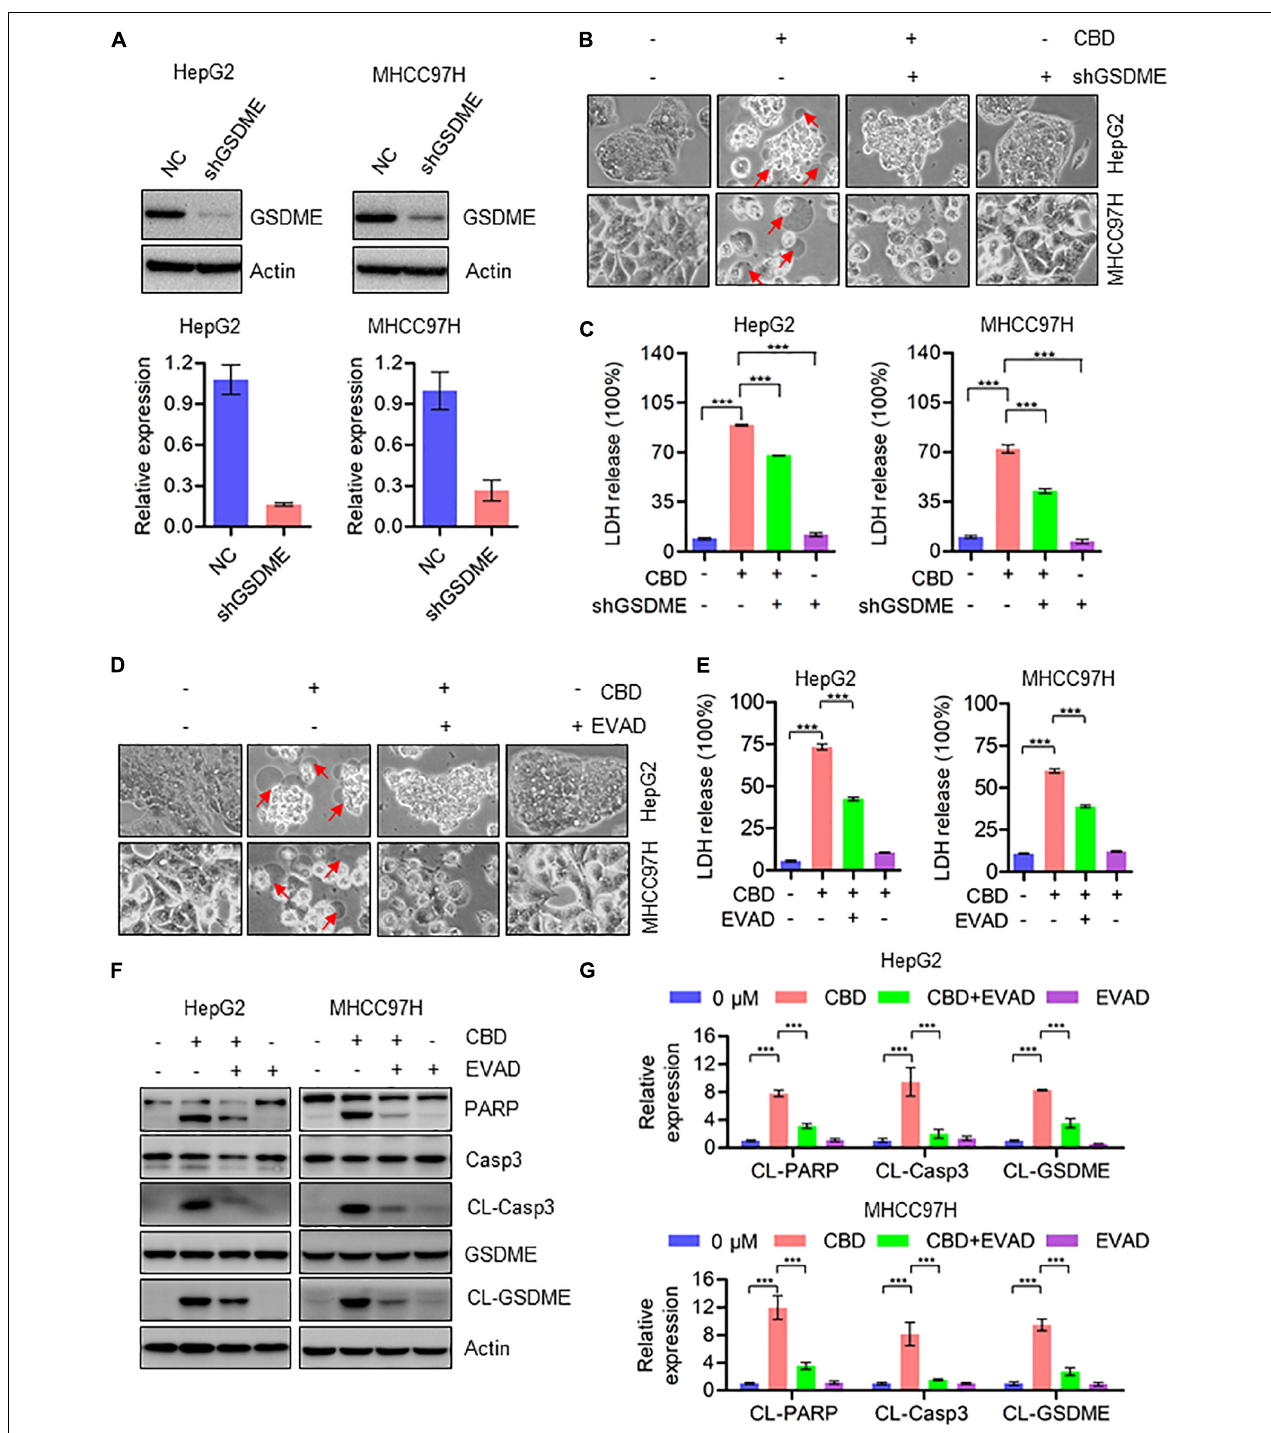
FIGURE 3 | Activation of caspase3/GSDME axis is essential for CBD-induced pyroptosis. (A) Western blot was performed to detect the efficiency of GSDME knockdown in HepG2 and MHCC97H cells. Actin was used as a loading control. The graphs represent the mean ± SD. (B) Representative morphological changes in control and GSDME knockdown HepG2 and MHCC97H cells after CBD exposure. (C) LDH release assays were performed on control and GSDME knockdown HepG2 and MHCC97H cells after CBD administration. (D) Representative morphological changes in CBD-treated HepG2 and MHCC97H cells with or without EVAD. (E) LDH release assays were performed on CBD-exposed HepG2 and MHCC97H cells in the presence or absence of EVAD. (F,G) Western blot analysis of PARP, Caspase-3, CL-Caspase-3, GSDME, and CL-GSDME in CBD (40 µ M) treated HepG2 and MHCC97H cells with or without EVAD after 24 h, and actin was used as a loading control. The graphs represent the mean ± SD. The meaning of ‘*‘ is statistically significant. *** p < 0.001.